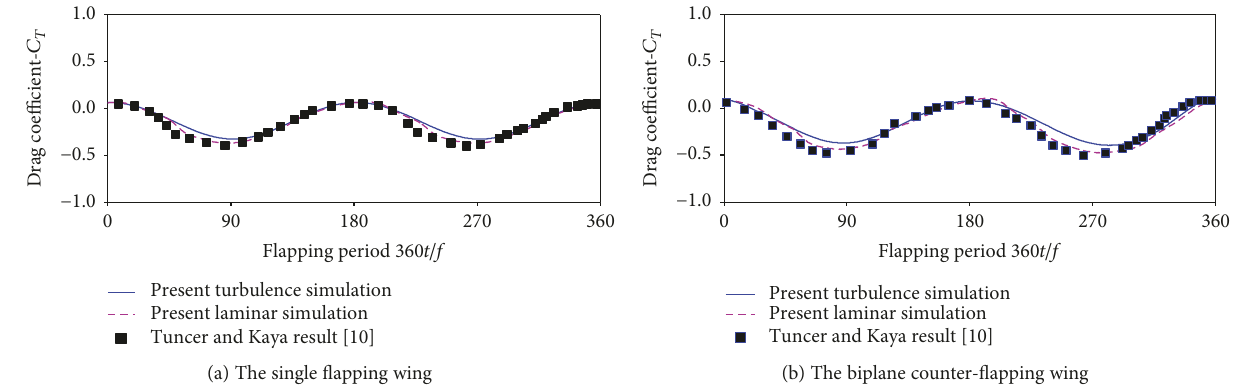
Figure 5: Time variation of drag coe ffi cients of the fl apping wing at Re = 1 × 10 4